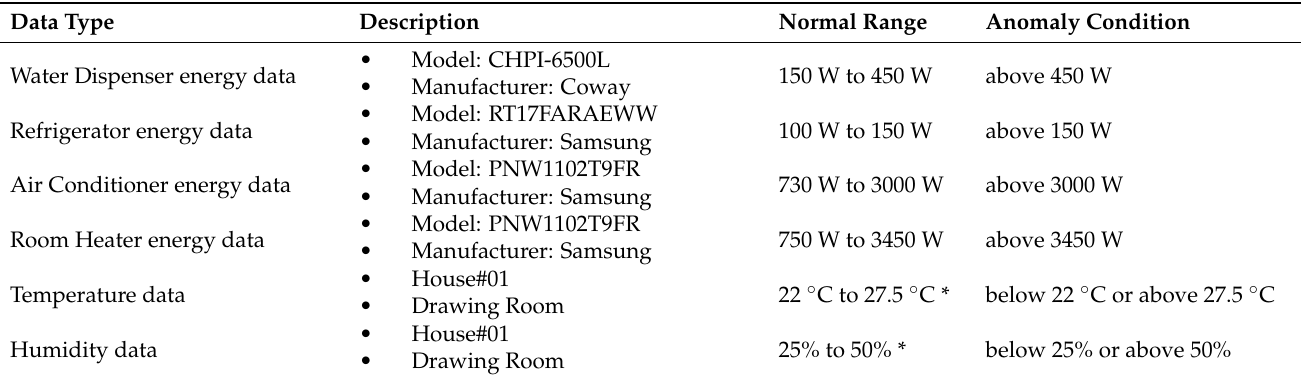
Table 5. Defining outlier conditions and acceptable ranges for various types of data.